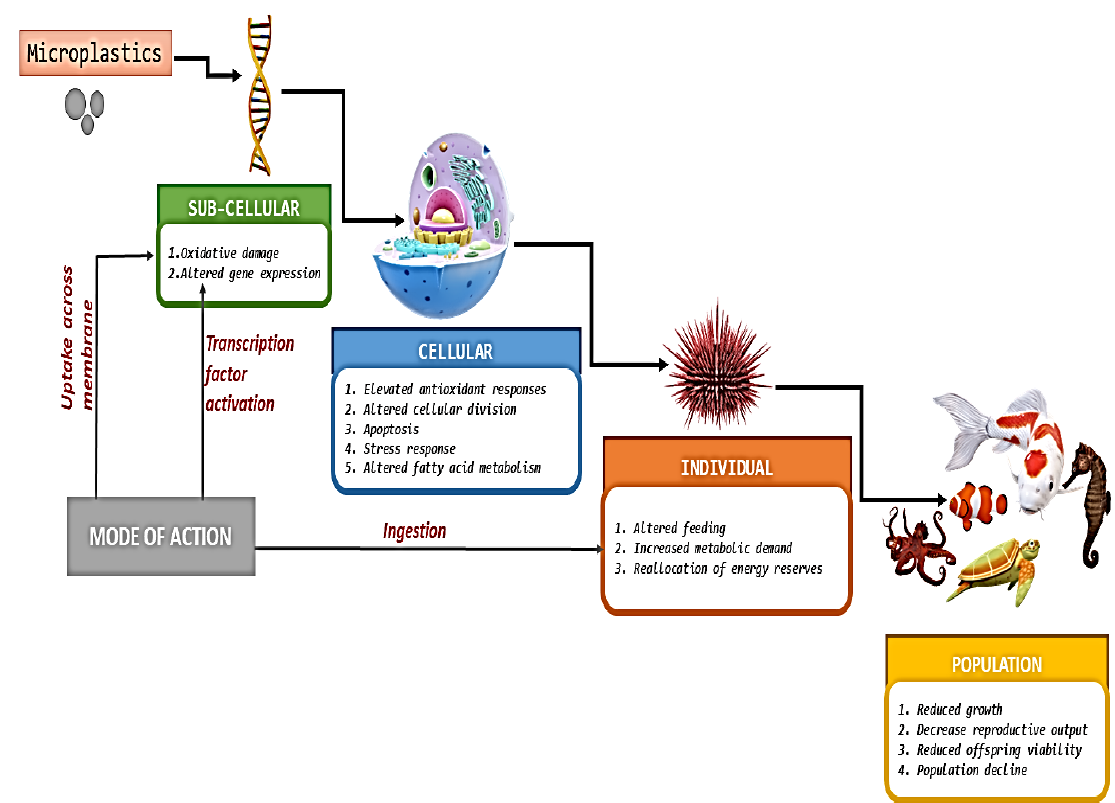
Figure 2. Effects of microplastics pollution on different levels of organizations. The biomagnification of microplastics takes place via the food chain, and they enter into the population. Gradually, they reach cell and subcellular levels in individual organisms, including human beings. It has been predicted that they can also interact with DNA of organisms to alter the gene expression and associated physiology.